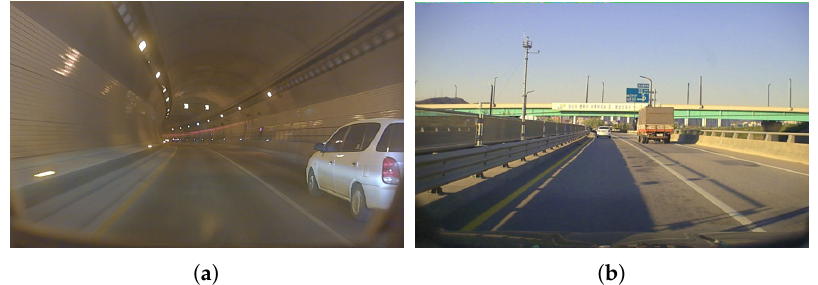
Figure 12. Examples of tunnel and guardrail with side lighting image: ( a ) tunnel image, and ( b ) guardrail with side lighting image.